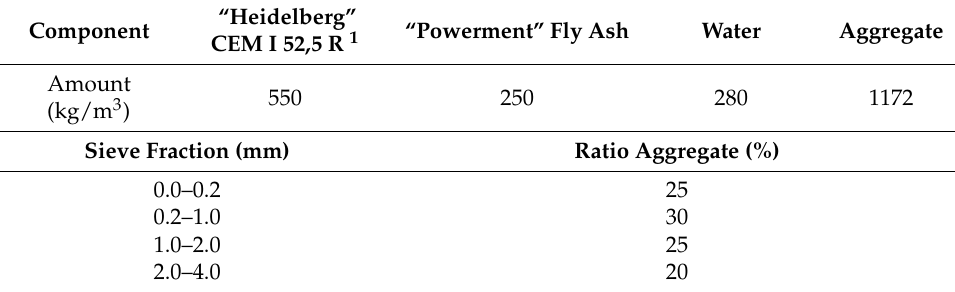
Table 1. Composition of concrete and sieve fraction.